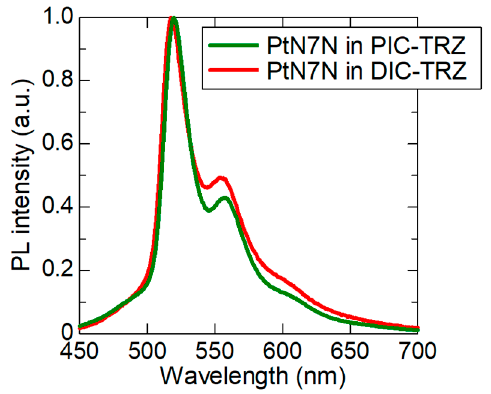
Figure 8. Normalized PL spectra of PtN7N in PIC–TRZ and DIC–TRZ.